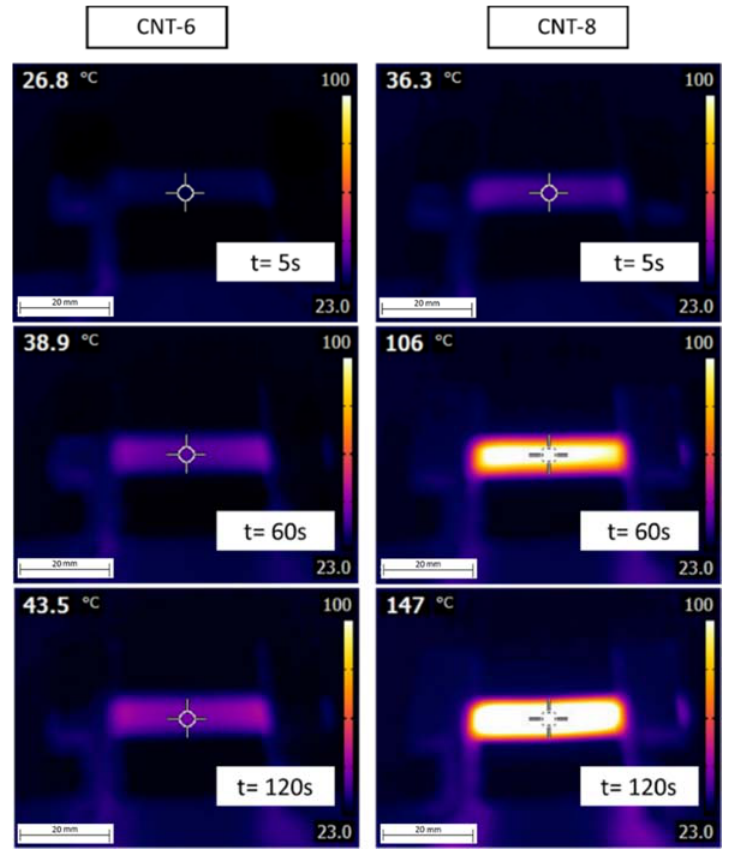
Figure 10. Infrared thermal imaging of CNT-6 ( left ) and CNT-8 ( right ) nanocomposites samples under an applied voltage of 12 V.